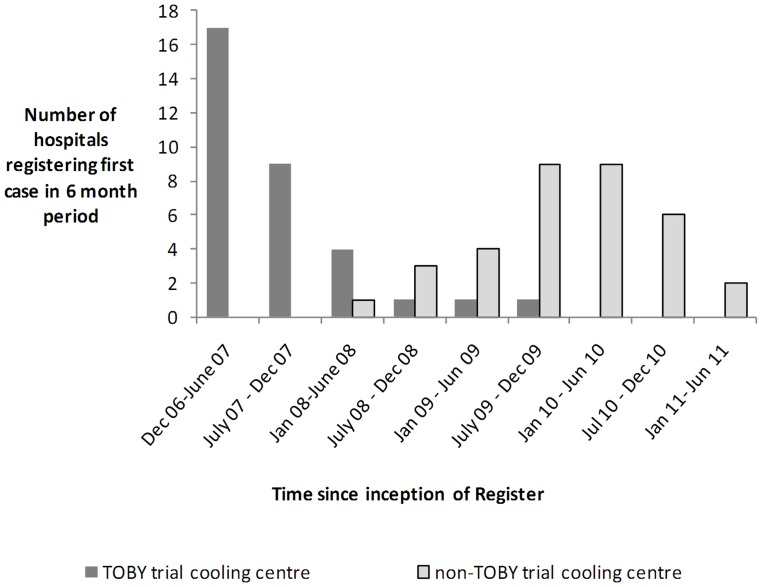
Number of hospitals registering first case in 6 month periods from inception of Register.Shaded bars indicate hospitals that participated in the TOBY trial and clear bars hospitals that did not participate in the TOBY trial.